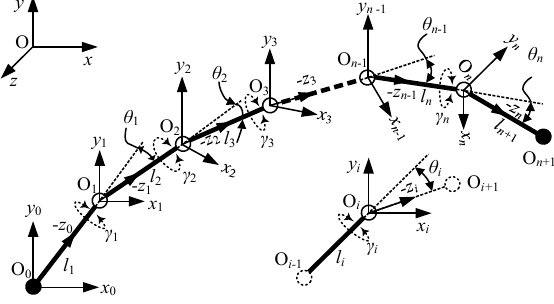
Figure 2. Coordinate system and joint parameters.